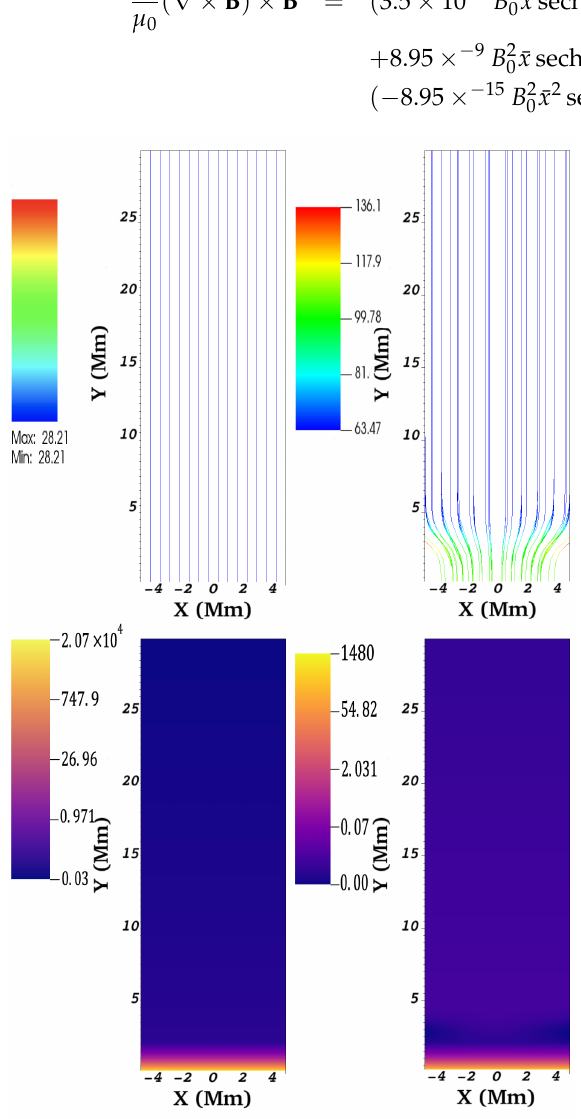
Figure 2. Upper : magnetic field lines for the vertical straight magnetic field configuration ( left ) and for the flux tube configuration ( right ) at the initial time, t = 0. The color bar represents the magnitude of the magnetic field | B | . Lower : The plasma- β corresponding to the vertical straight magnetic field ( left ) and the flux tube ( right ) at the initial time, t =